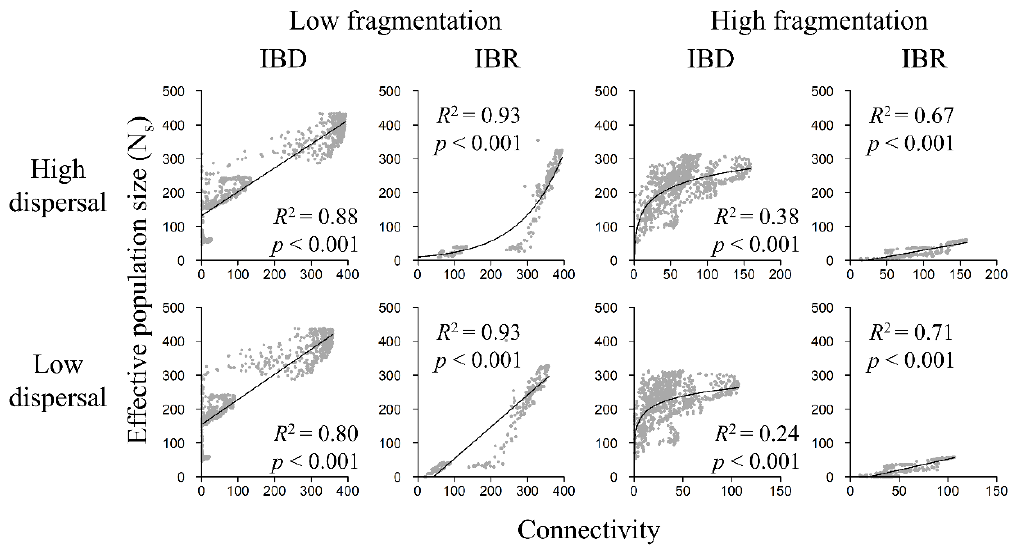
Figure 7. Relationship between N s and landscape connectivity in the low-fragmentation model (left two columns) and the high-fragmentation model (right two columns). Top row: high-dispersal scenario (300 km). Bottom row: low-dispersal scenario (200 km). Effective population size (y-axis) is calculated with software sGD. Connectivity (x-axis) is quantified in terms of cumulative resistant kernel density, representing the expected density of dispersing individuals. Gray markers represent the mean of 100 Monte Carlo simulation runs for each node. Adjusted R 2 and p -values are shown.